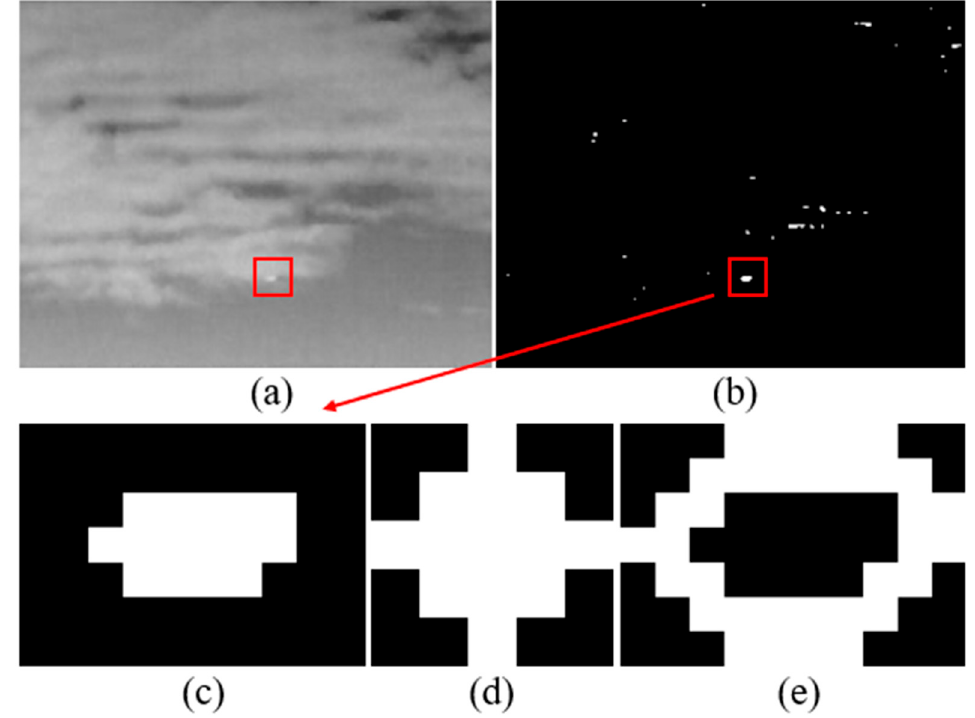
Figure 4. Illustrations of ( a ) input image, ( b ) binarized mask, ( c ) local operation region, ( d ) binarized filter kernel when r = 2, and ( e ) the surrounding region represented by the mask. filter kernel when r = 2, and ( e ) the surrounding region represented by the